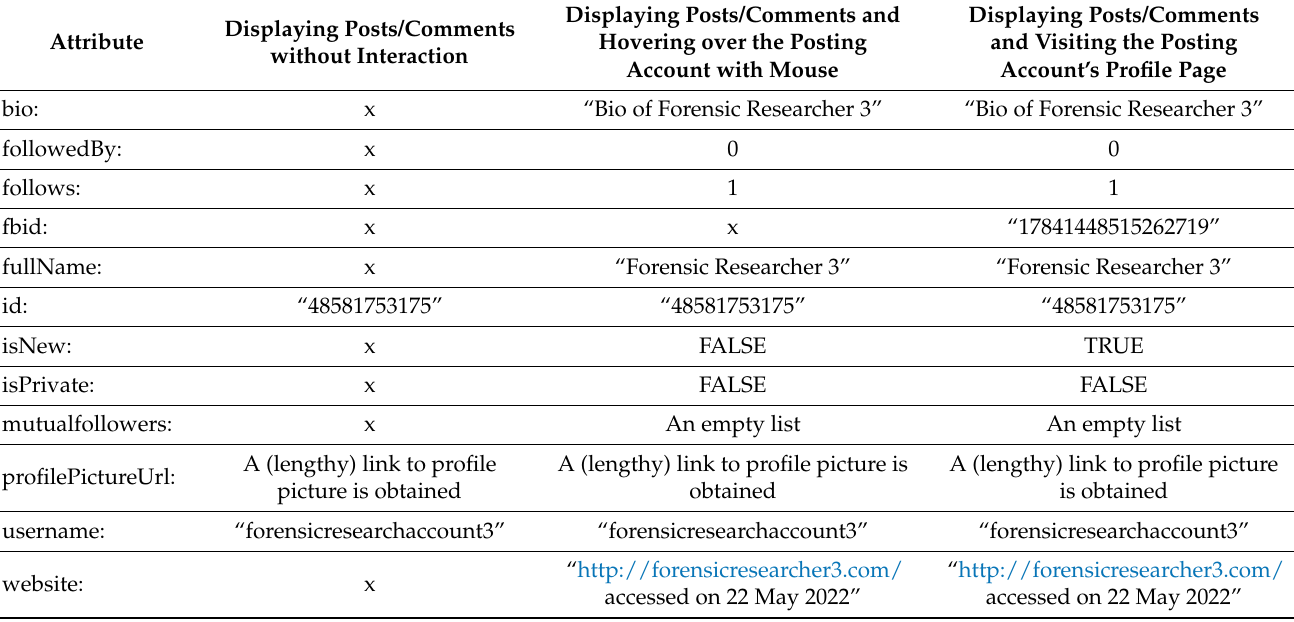
Table 5. Artifacts Found in users.users Record with User Profile